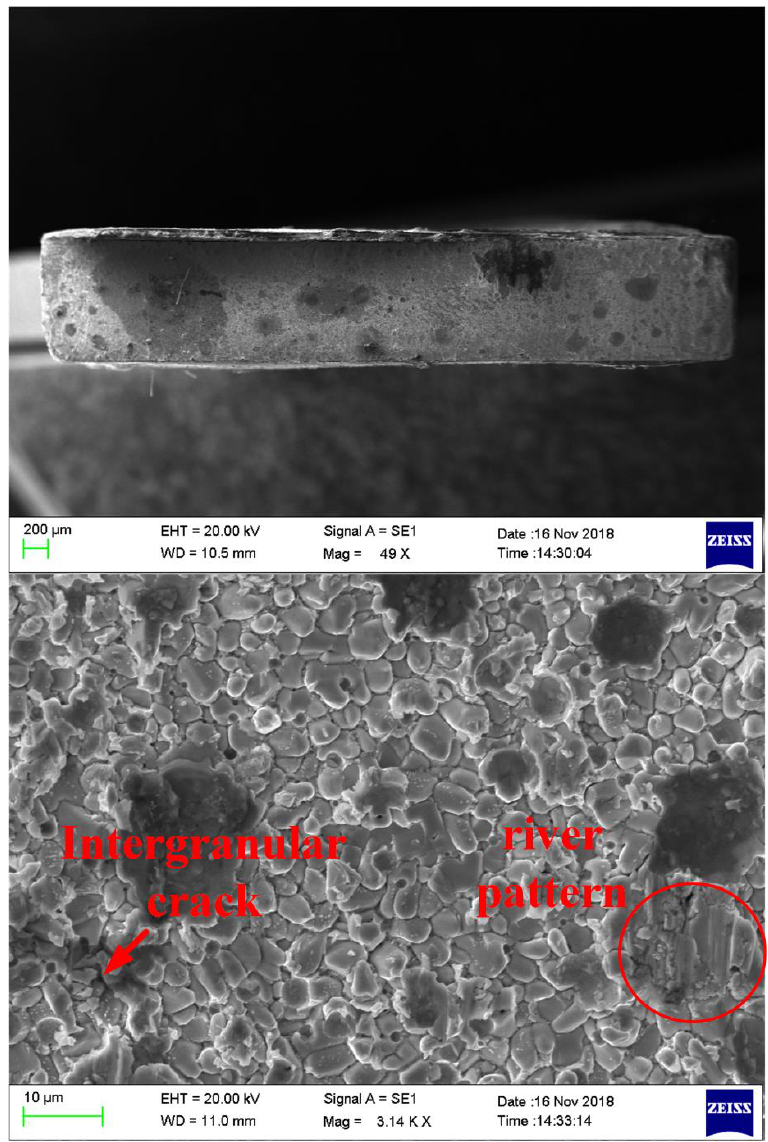
Figure 16. SEM graph of fracture surface at − 100 °C (brittle).